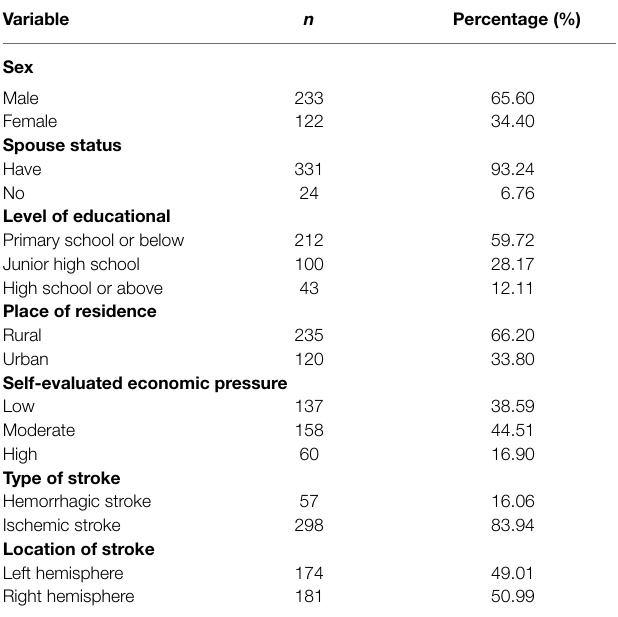
TABLE 1 | General characteristics of the sample ( N =